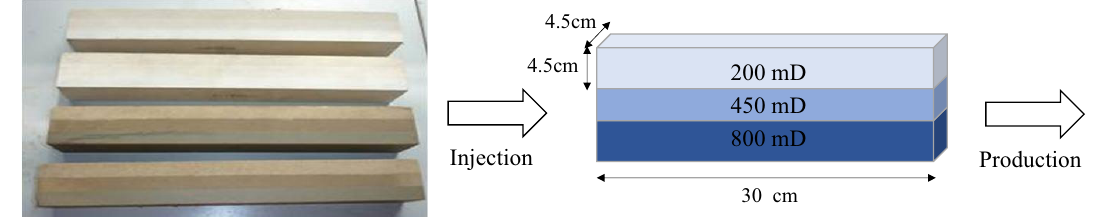
Fig. 8 (left) Heterogenous sand pack; (right) Schematic of core flooding